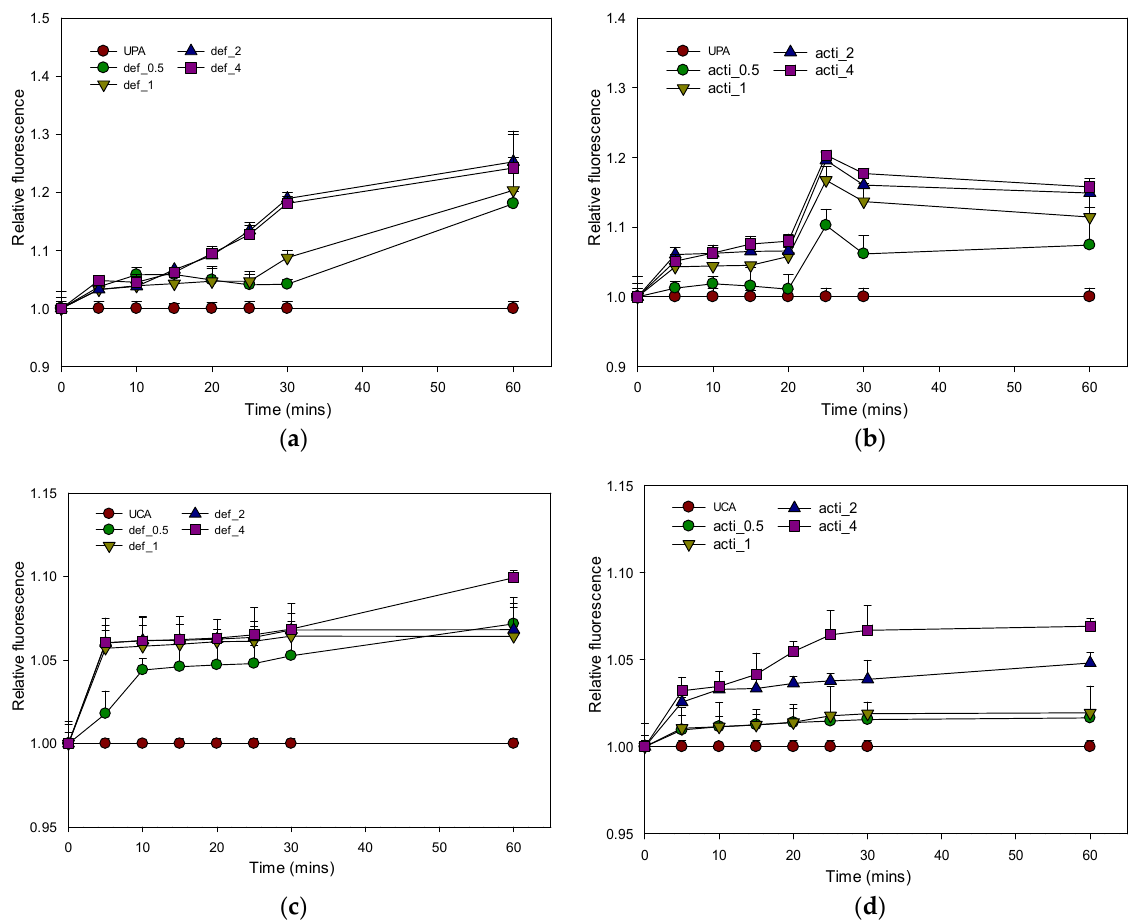
Figure 12. Relative fluorescence of PI uptake to assess plasma-membrane permeability of recombinant defensin-d2 and actifensin against P. aeruginosa and C. albicans . ( a ) defensin-treated P. aeruginosa ( b ) actifensin-treated P. aeruginosa ( c ) defensin-treated C. albicans ( d ) actifensin-treated C. albicans . Untreated samples were used for normalization. UPA—untreated P. aeruginosa ; UCA—untreated C. albicans ; def—defensin-d2; acti—actifensin. Graphs show means and standard error means (as error bars) of triplicate data per treatment.